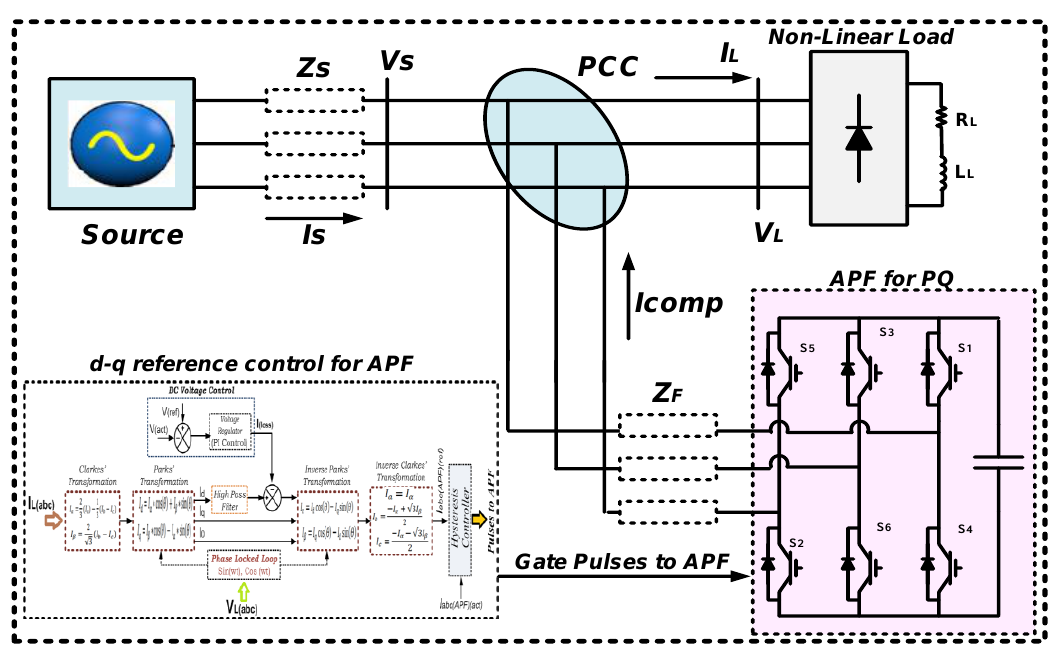
Figure 4 . Complete representation of d-q reference frame theory based APF in power